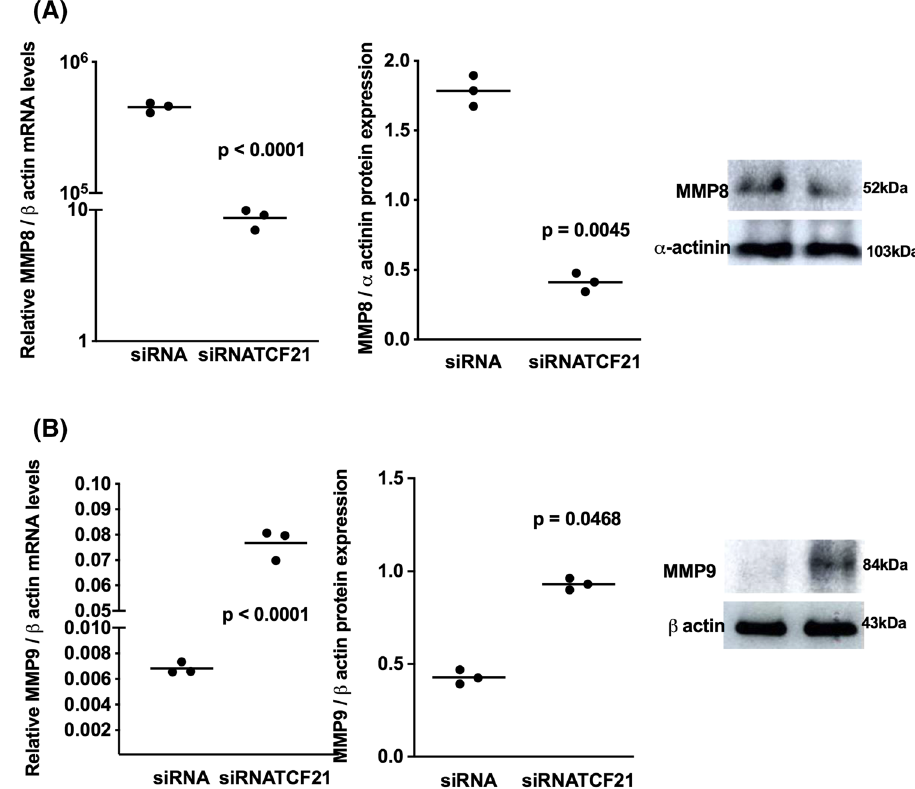
Fig. 7 Inhibition of TCF21 inhibited MMP-8 and promote MMP-9 expression. A Rela- tive mRNA level and protein expression of metallopro- teinase 8 (MMP-8) and with representative immunoblot experiment; B Relative mRNA level and protein expres- sion of metalloproteinase 9 (MMP-9) and representative immunoblot in ACAPed-T7siR- NATCF21. The experiments were performed in triplicate and repeated three times. The results were expressed as the mean ± SD. Statistical significance was assessed by unpaired t